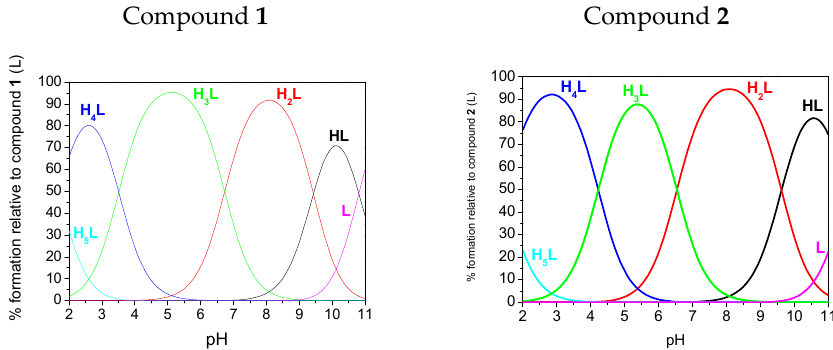
Figure 4. Species distribution diagrams of the ligands calculated based on potentiometric results.